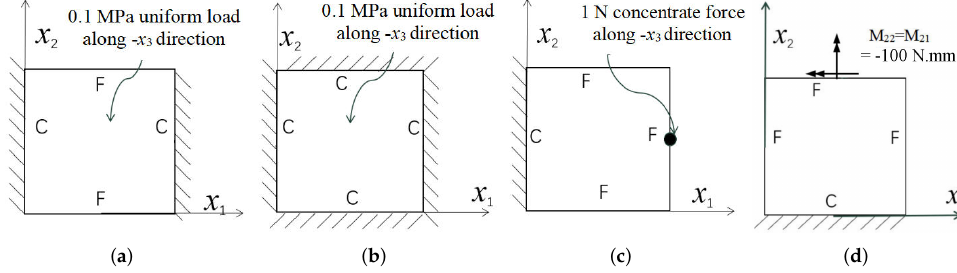
Figure 16. Boundary and load conditions for bending behavior analysis of 2D-PWL and 3D-TCP.